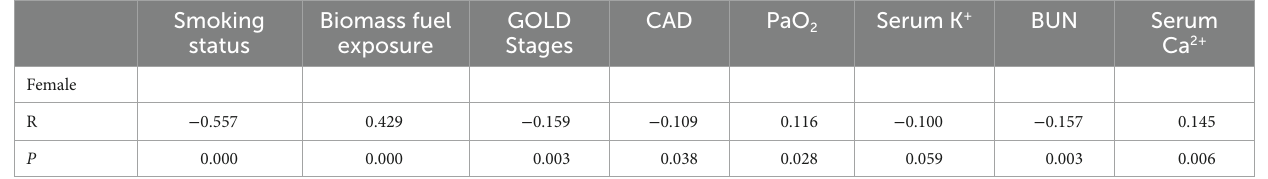
TABLE 4 The correlations between sex and smoking, biomass fuel exposure, GOLD stages, CAD, PaO2, serum K + , BUN, and serum Ca2 + in patients with AECOPD ( n =